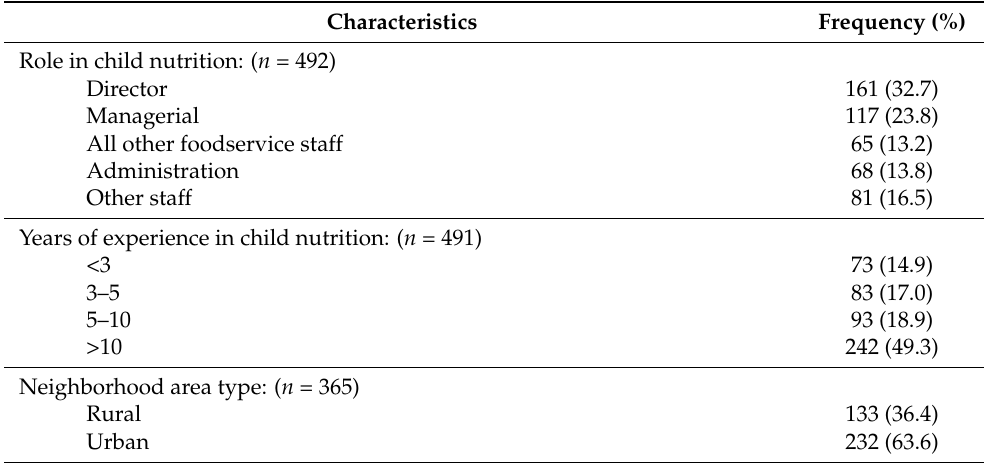
Table 1. Characteristics of the Training & Learning Preferences Survey for Illinois Child Nutrition Program Survey